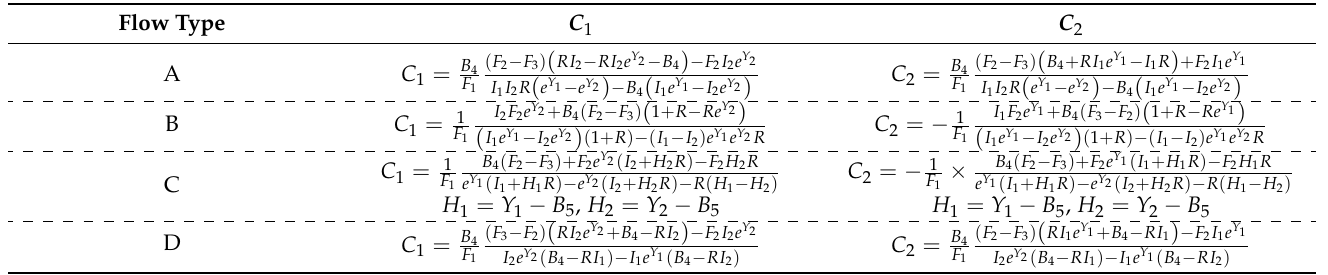
Table 3. Two undetermined coefficients, C 1 and C 2 , in Equations (5) and (6) for all flow types.